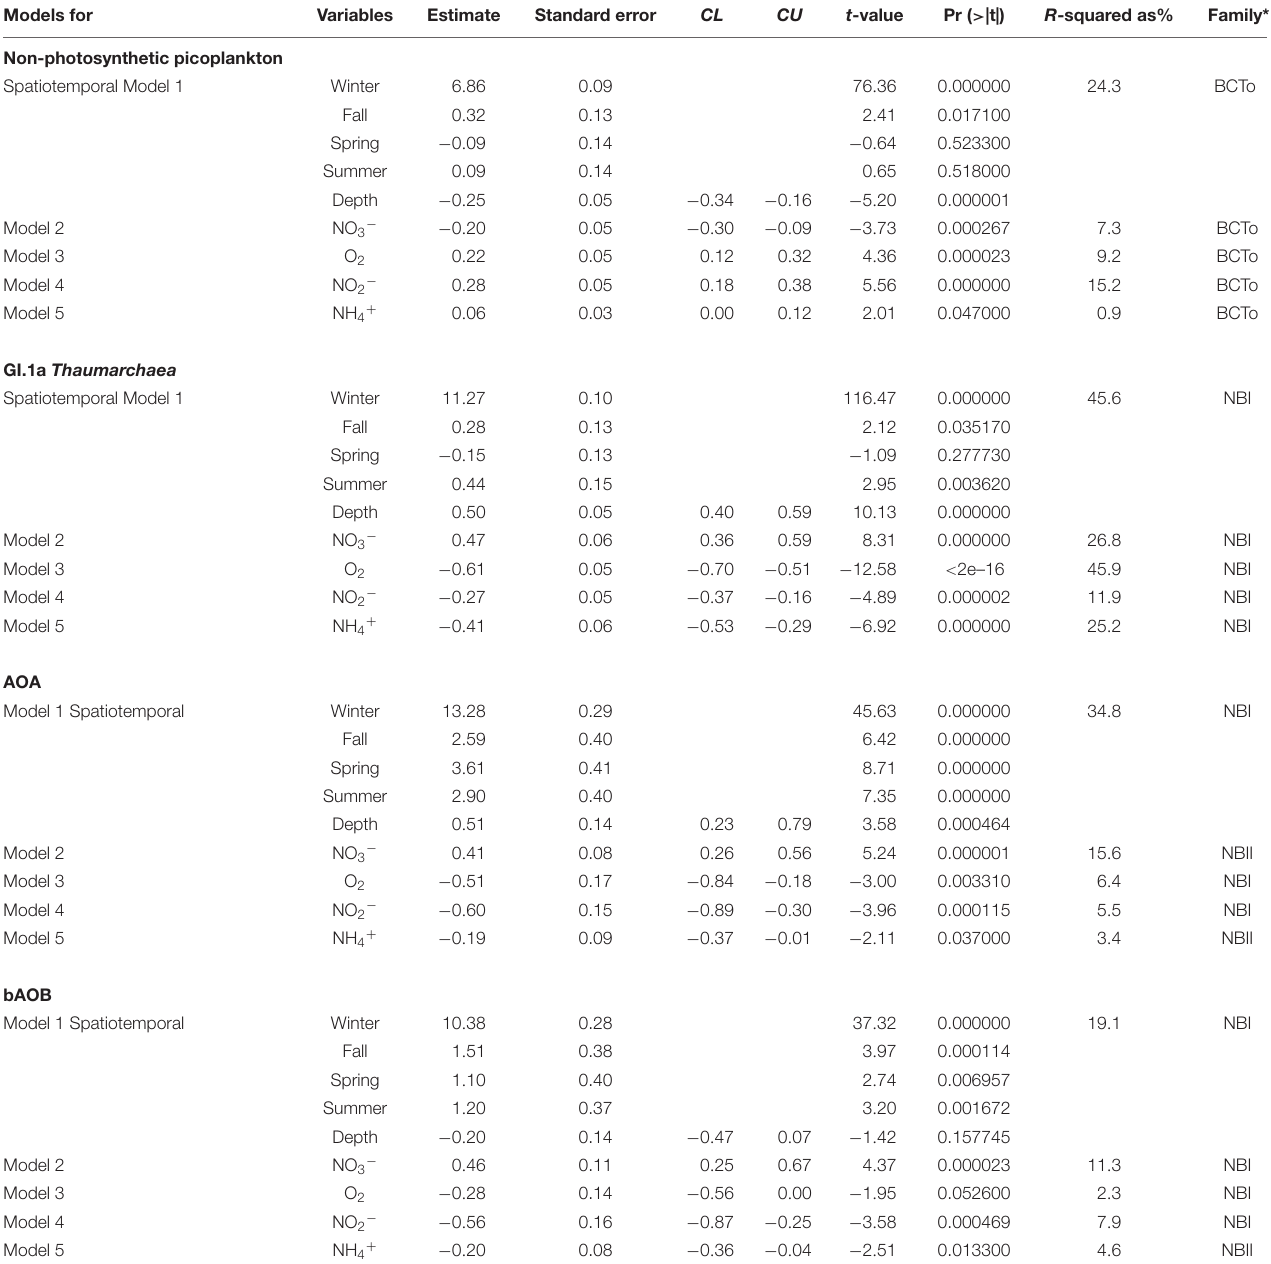
TABLE 1 | Parameters obtain from the microbial modeling (GAMLSS) as function of different predictor variables. Models for Variables Estimate Standard error CL CU t -value Pr ( > |t|) R -squared as%